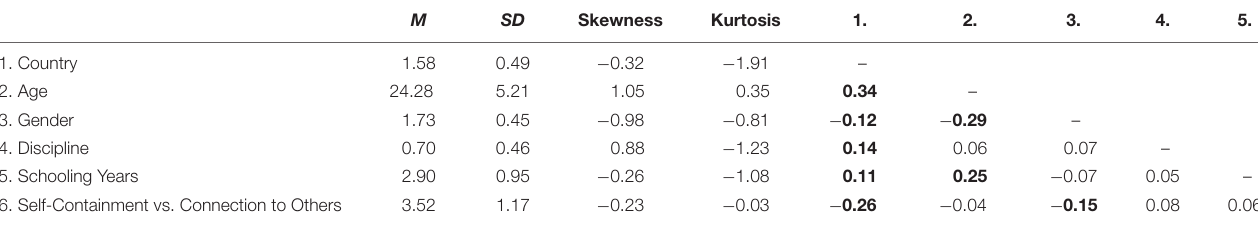
TABLE 1 | Means, standard deviations, and correlation matrix for the variables in Study